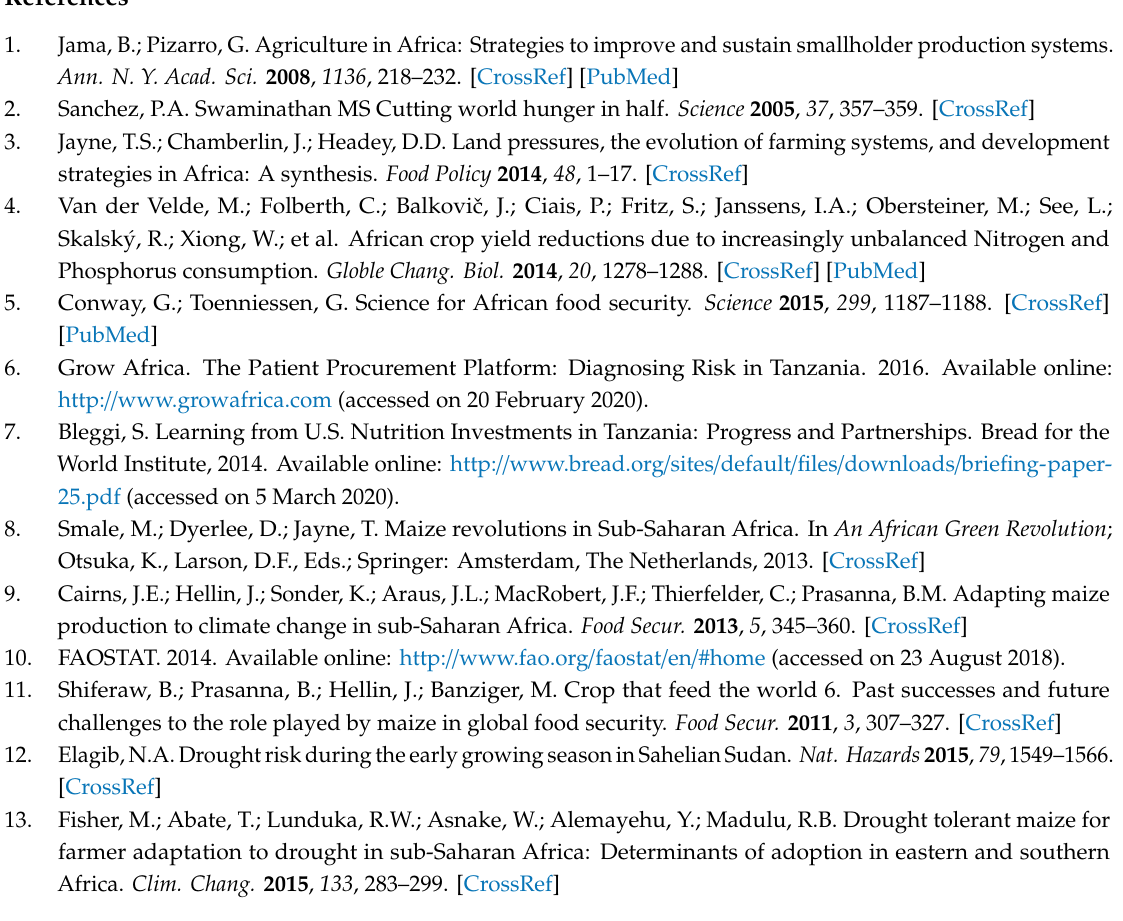
Figure S1: Areas with yield susceptibility to sowing delay and their estimated yield loss: (a) Correlation Coe ffi cient between yields and days of sowing delay, (b) estimated yield loss due to a 5-day delay. Figure S2: Areas with yield susceptibility to insu ffi cient growing-season rainfall and their estimated yield loss: (a) Correlation Coe ffi cient between yields and growing-season precipitation, (b) estimated yield loss for a one-hundred-year insu ffi cient rainfall event. Figure S3: Distribution of (a) mean and (b) minimum yields over the 30 years for management strategies along latitudes. Figure S4: Spatial patterns of simulated mean yields over years of 1984–2013 under management strategies a–s outlined in Table 1. Figure S5: Spatial patterns of simulated minimum yields over years of 1984–2013 under management strategies a-s outlined in Table 1. Grey color indicates areas that experienced at least once over the 30 years a poor harvest (i.e., yield below 1 t / ha). Figure S6: Possibility of poor harvest (i.e., yield below 1 t / ha) over the 1984–2013 time period under management strategies a–s outlined in Table 1. Figure S7: Yield loss due to a 5-day delay of sowing under management strategies a–s outlined in Table S1. White areas indicate either positive yield change or insignificant relationship between sowing delay and simulated yields. Figure S8: Yield loss due to insu ffi cient growing-season rainfall (one-hundred-year event) under management strategies a–s outlined in Table 1. White areas indicate either positive yield change or insignificant relationship between growing-season rainfall and simulated